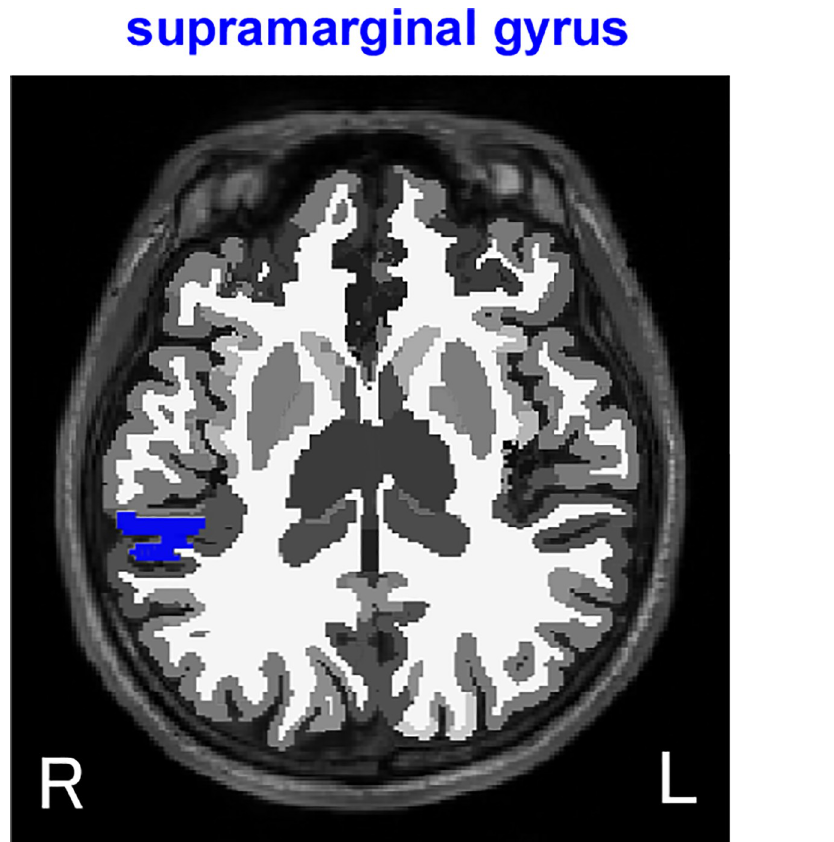
Fig 3. Location of the right supramarginal gyrus in axial view (blue